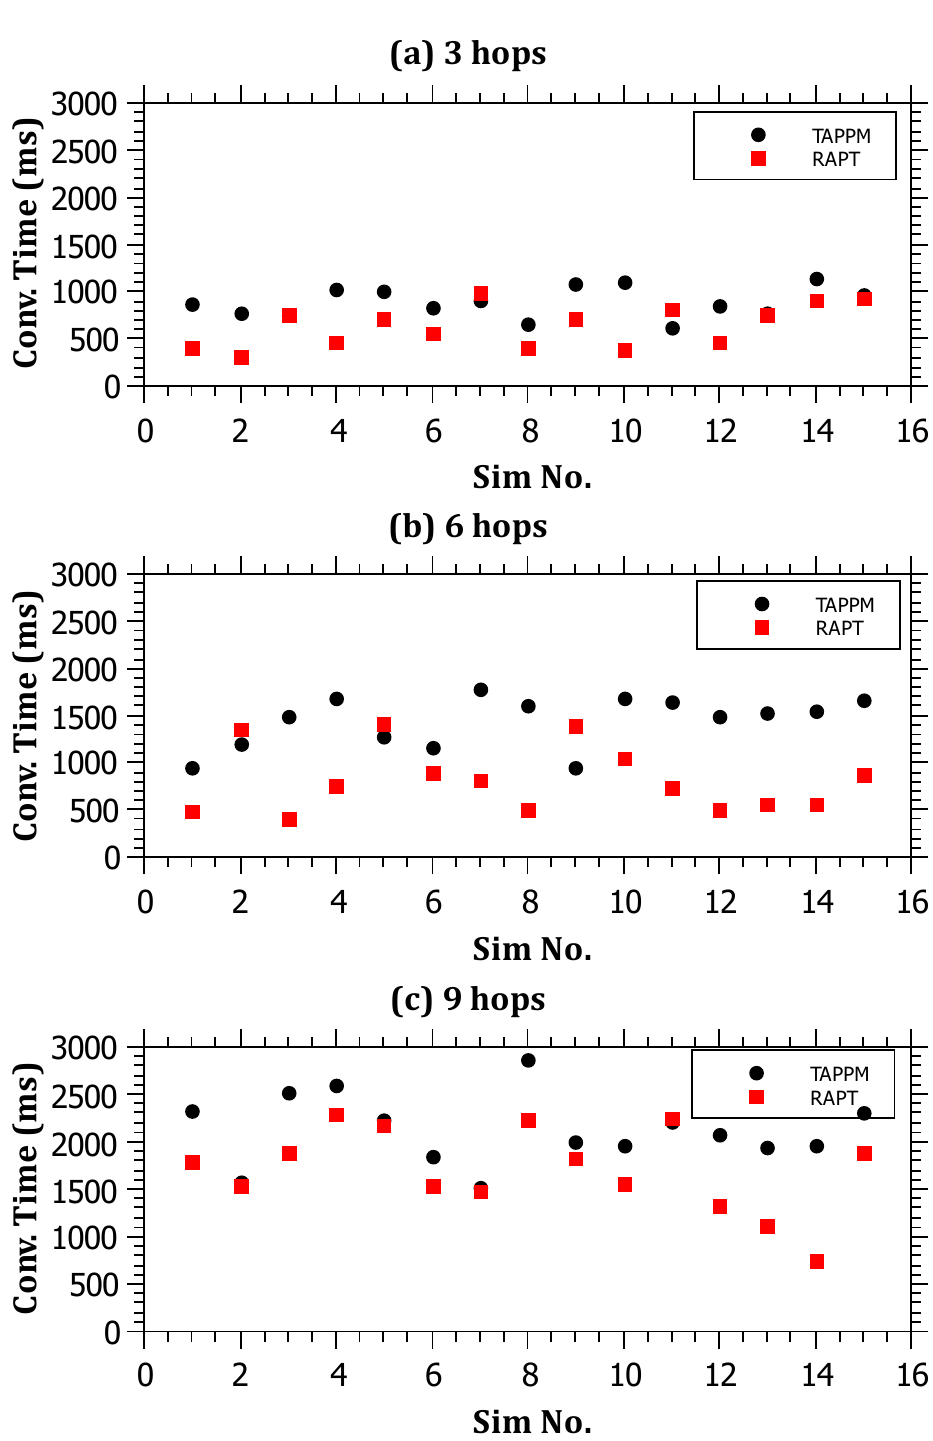
Figure 11. The relationship between the distance of the attack and the convergence time for ( a ) 3 hops; ( b ) 6 hops; and ( c ) 9